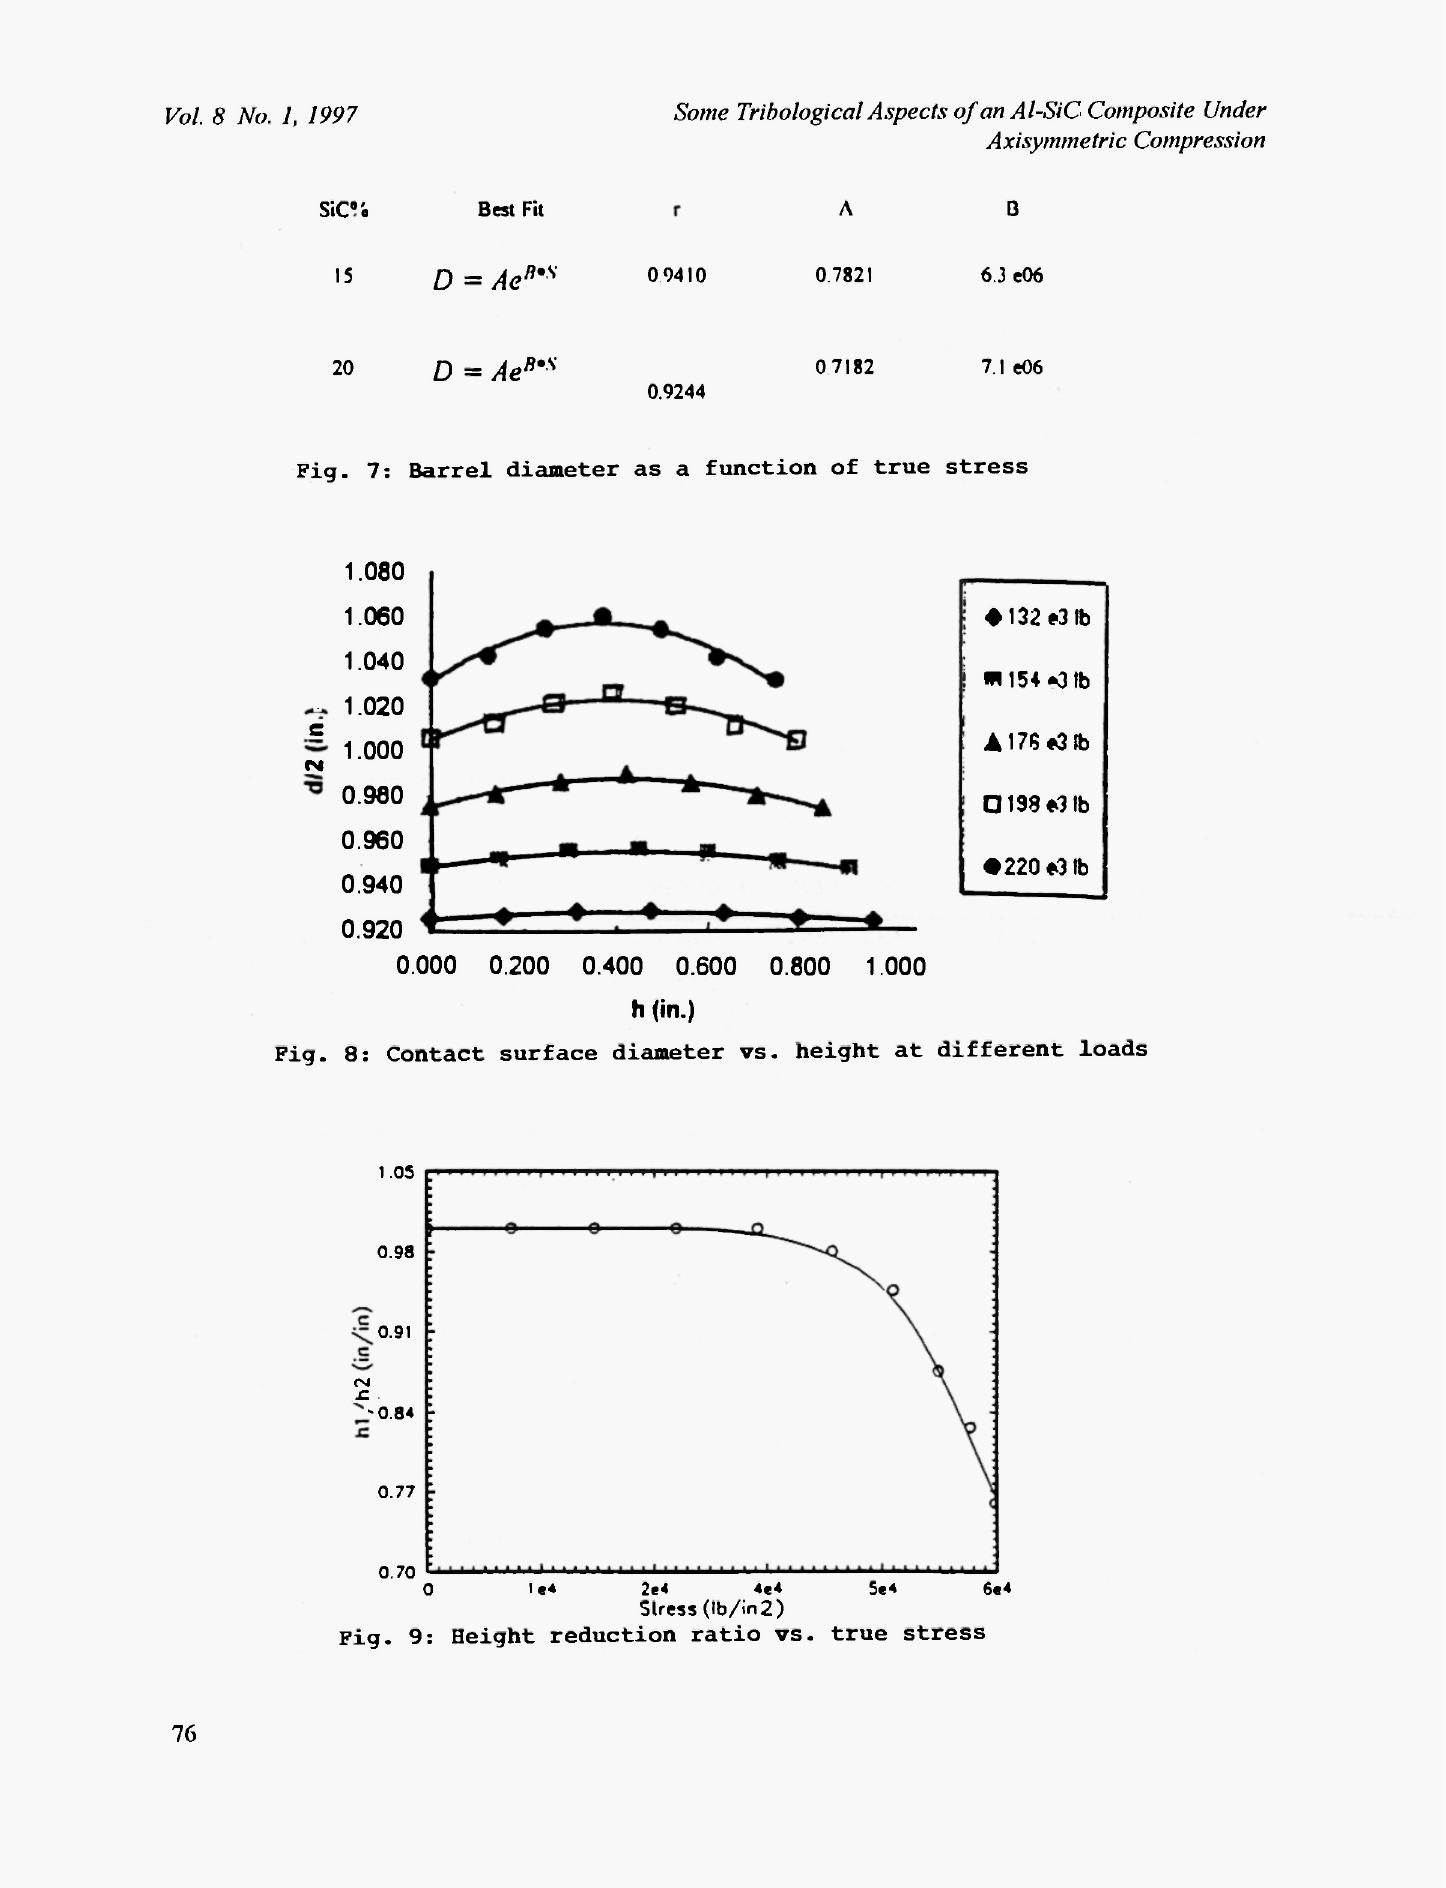
Fig. 9: Height reduction ratio vs. true